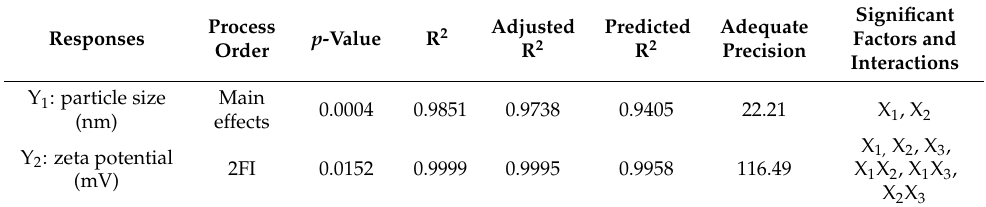
Table 3. Statistical analysis output of responses data of 2 3 factorial design used for formulation of SIT-MEL nano-sized